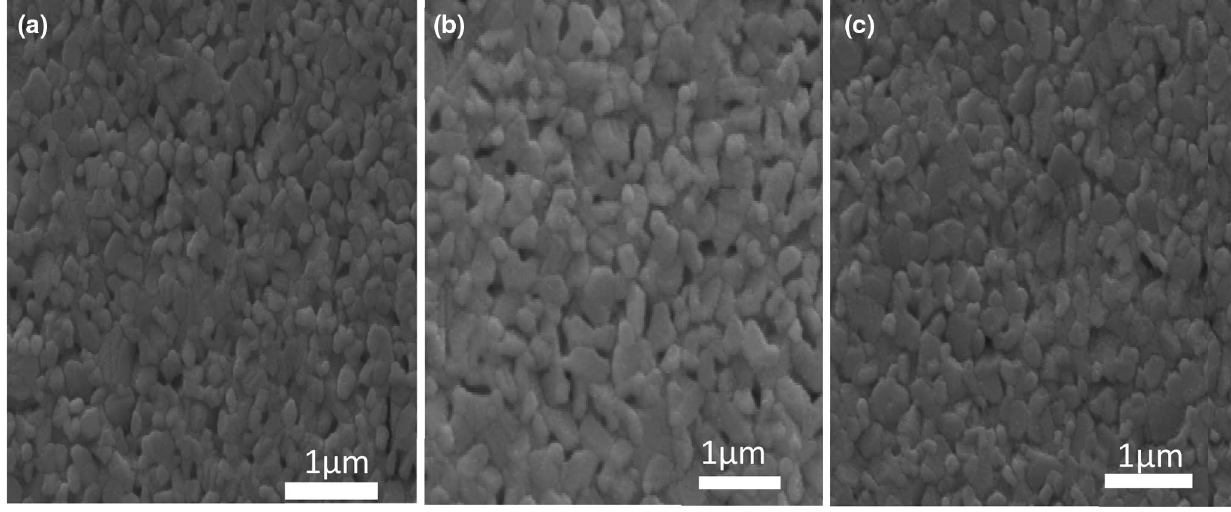
Fig. 3 SEM images of films aged at different time of a 0 s; b 200 s and c 600 s, before thermal annealing at 90 °C for 5